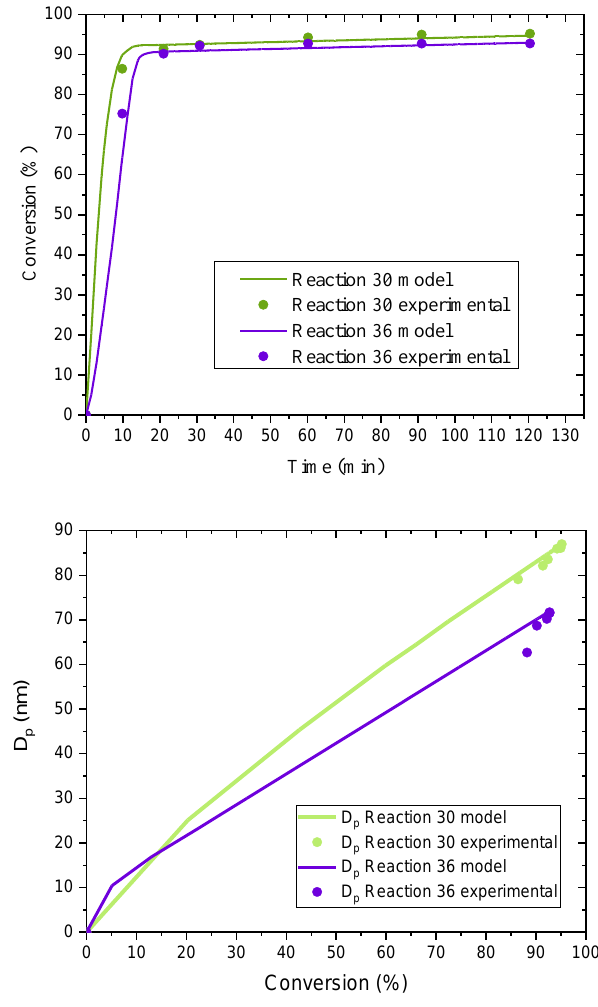
Figure 9. Comparison of simulation (POLYRED) and experimental data for monomer conversion vs. reaction time ( top ) and D p vs. monomer conversion ( bottom ) for experiments E30 and E36.